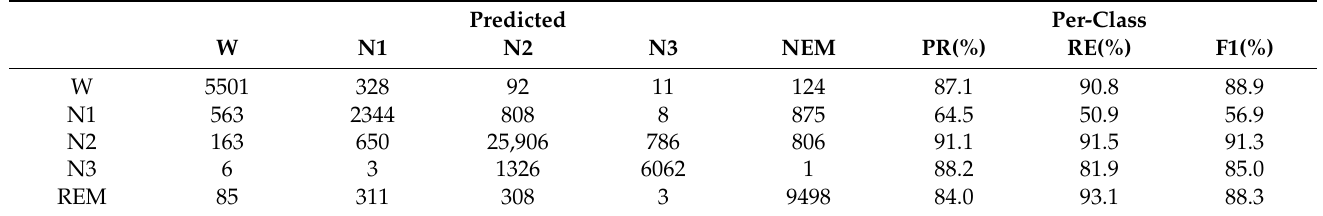
Table 4. Confusion matrix and per-class metrics of applying Siamese AEs to the baseline sleep staging model on the MASS-SS3 dataset, using 31-fold